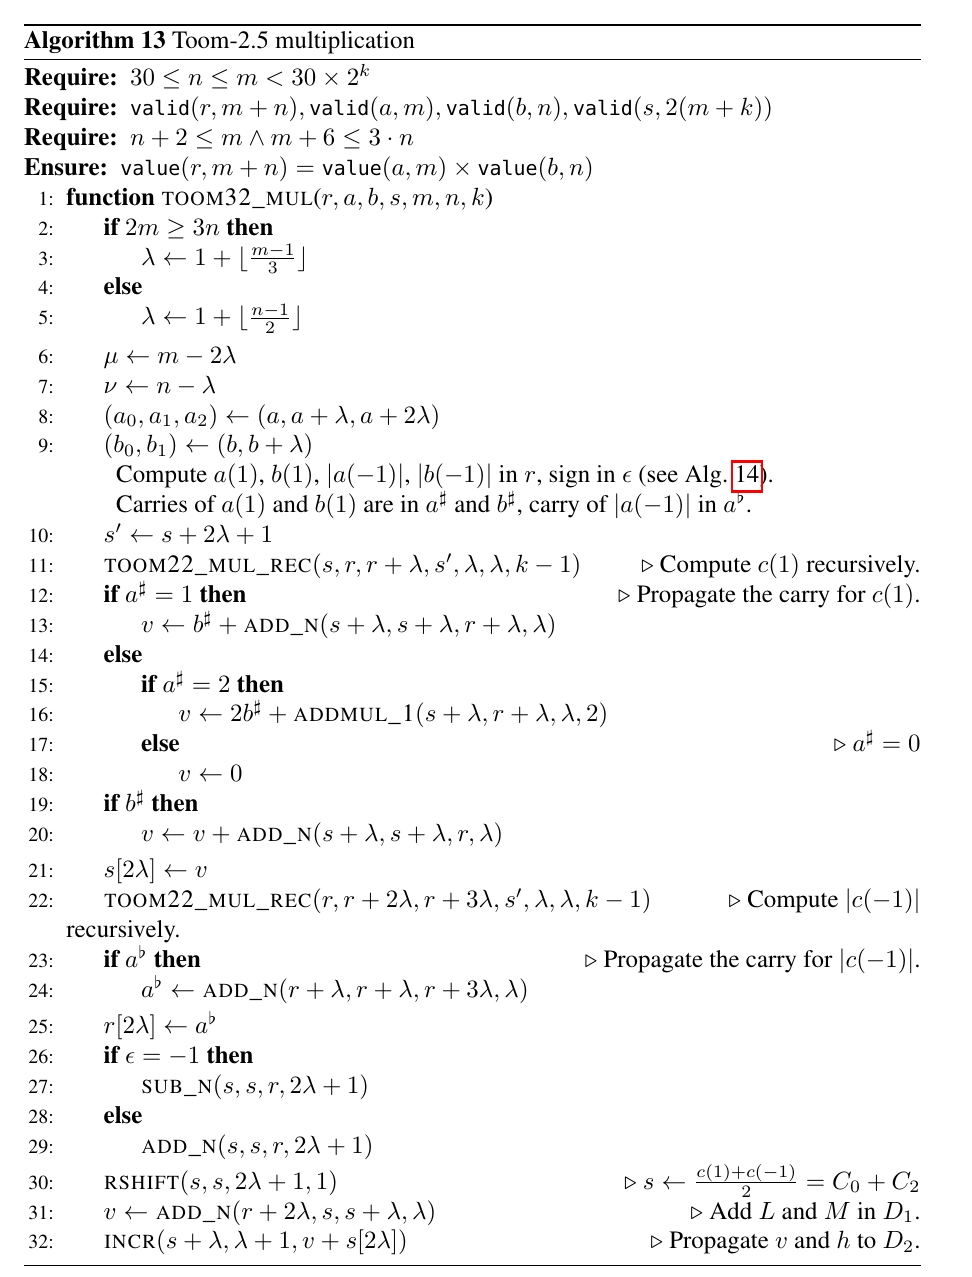
Algorithm 13 Toom-2.5